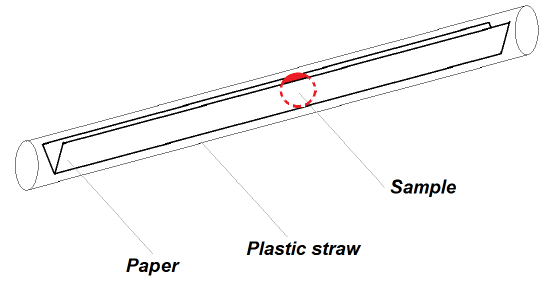
Figure 7. Schematics of sample configuration with V-shaped paper and a standard plastic straw.